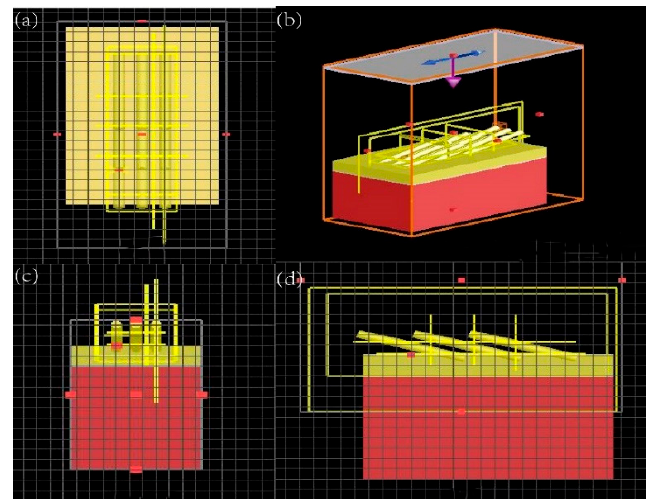
Figure 1. Models of Au nanorods (AuNRs) for finite-difference time-domain (FDTD) simulation: ( a ) XY plane, ( b ) oblique view, ( c ) XZ plane, ( d ) YZ plane.